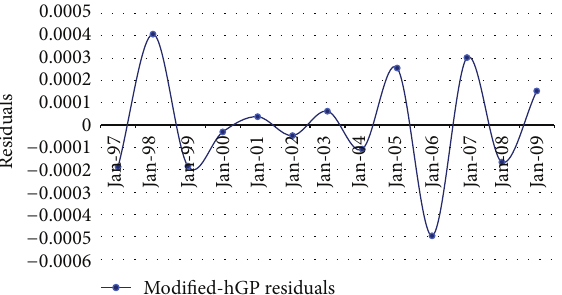
Figure 14: Residuals of the modified-hGP model in fitting for the OECD mobile contract subscribers.